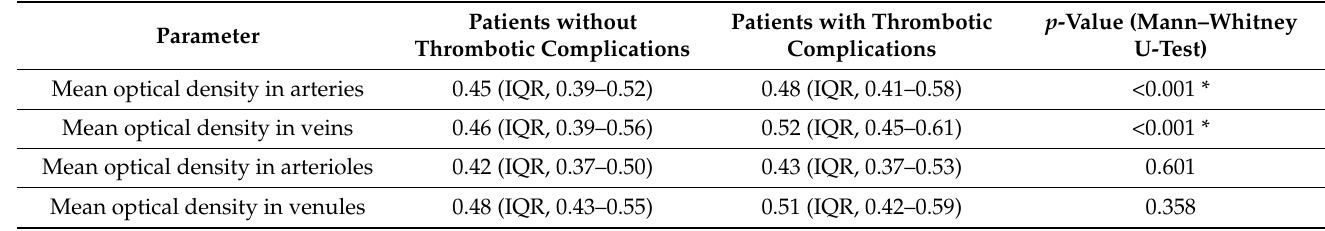
Table 3. Comparative intergroup analysis of mean optical density in pulmonary vascular endothelium in groups of patients with/without thrombotic complications.